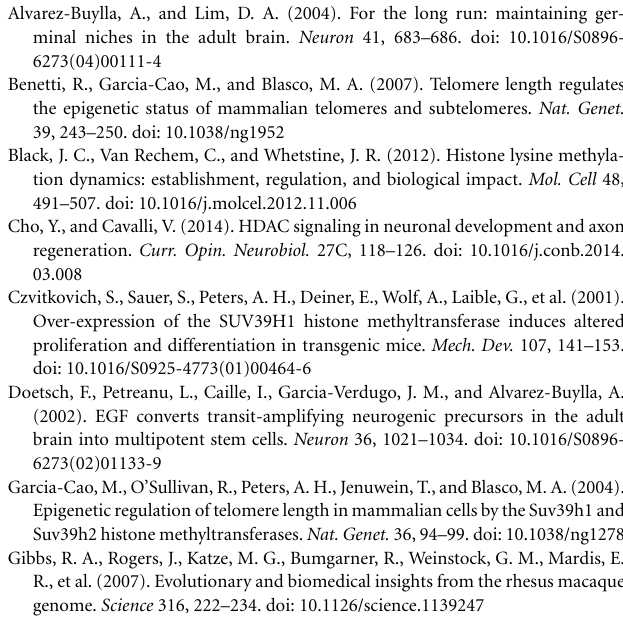
Supplemental Figure 1 | Protein Ubiquitination Pathway. One of top four canonical pathways predicted by Ingenuity Pathway Analysis for H3K9me3 enriched genes in baboon SVZ cells. The shaded focus genes (red highlight) were enriched with H3K9me3 identified by ChIP-Seq analysis. The node shape reflects the role of each element in the pathway and the direction and arrowhead shapes of each edge represent different types of interactions (see key at bottom-left panel). Supplemental Figure 2 | P53 signaling pathway. One of top four canonical pathways predicted by Ingenuity Pathway Analysis for H3K9me3 enriched genes in baboon SVZ cells. The shaded focus genes (red highlight) were enriched with H3K9me3 identified by ChIP-Seq analysis. The node shape reflects the role of each element in the pathway and the direction and arrowhead shapes of each edge represent different types of interactions (see key in Supplemental Figure 1 ). Supplemental Figure 3 | Hepatic stellate cell activation pathway. One of top four canonical pathways predicted by Ingenuity Pathway Analysis for H3K9me3 enriched genes in baboon SVZ cells. The shaded focus genes (red highlight) were enriched with H3K9me3 identified by ChIP-Seq analysis. The node shape reflects the role of each element in the pathway and the direction and arrowhead shapes of each edge represent different types of interactions (see key in Supplemental Figure 1 ). Supplemental Figure 4 | The integrated analysis between RNA-Seq and the set of H3K9me3-enriched genes in the acetylation category from our GO analysis. 138 of H3K9me3-enriched genes in acetylation category are detectable by RNA-Seq, whereas 24 genes are not detectable by RNA-Seq. For characterization of these detectable or undetectable H3K9me3-enriched genes in baboon SVZ cells, IPA prediction reveals the top canonical networks and pathways as shown in the box. Supplemental Table 1 | (i) Summary of Enriched Loci of H3K9me3; (ii) Gene Ontology by DAVID for H3K9me3-enriched genes in Baboon SVZ Cells; (iii) Integrated analyses for ChIP-Seq and RNA-Seq; (iv) A subset of H3K9me3-enriched genes was characterized as imprinting